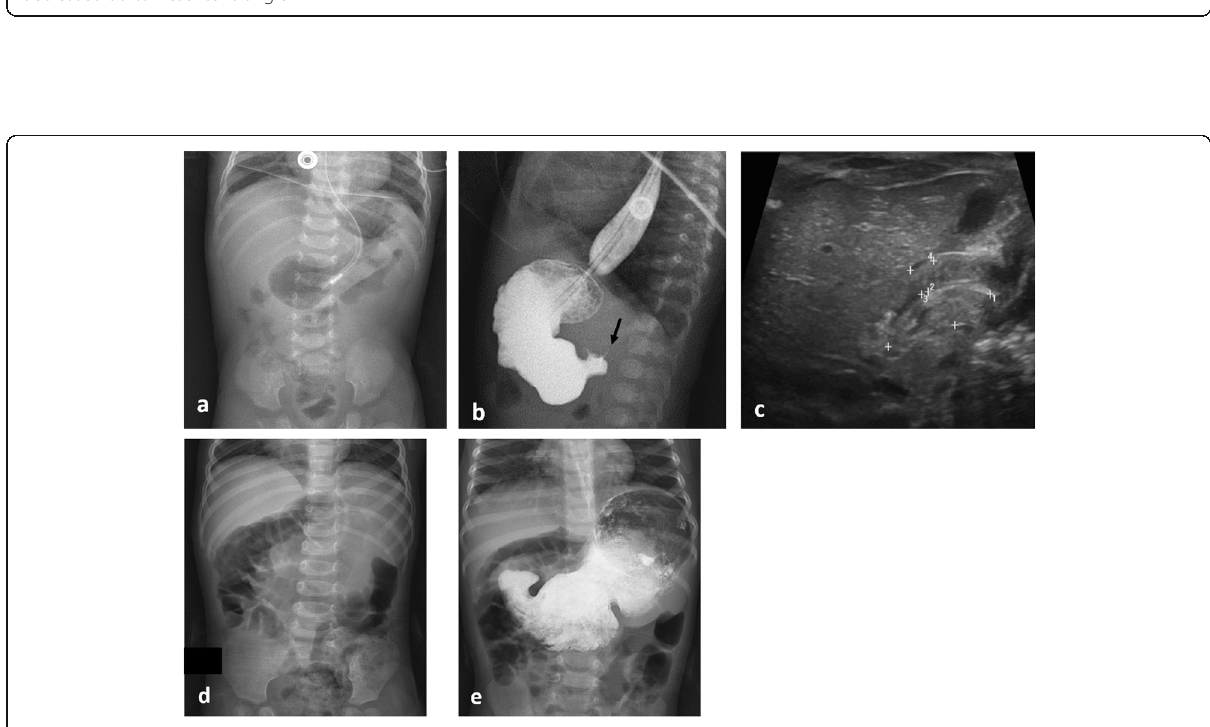
Fig. 4 Two different patients with gastric outlet obstruction. Upper row neonate with infantile hypertrophic stenosis; a ) plain AP view shows air- filled stomach with wave-like contour (caterpillar sign) with paucity of abdominal gas distally; b ) lateral view shows very narrowed pyloric canal (string sign, arrow) with delayed gastric emptying; c ) ultrasound scan of the pylorus reveals elongated thickened pyloric canal, with length of 20 mm, transverse diameter of 11 mm and single wall thickness 4 mm. d , e ) patient with idiopathic acquired gastric outlet obstruction; d ) plain AP view shows dilated fluid filled stomach displacing the surrounding gas filled bowel loops; e ) UGI series shows the dilated stomach with delayed gastric